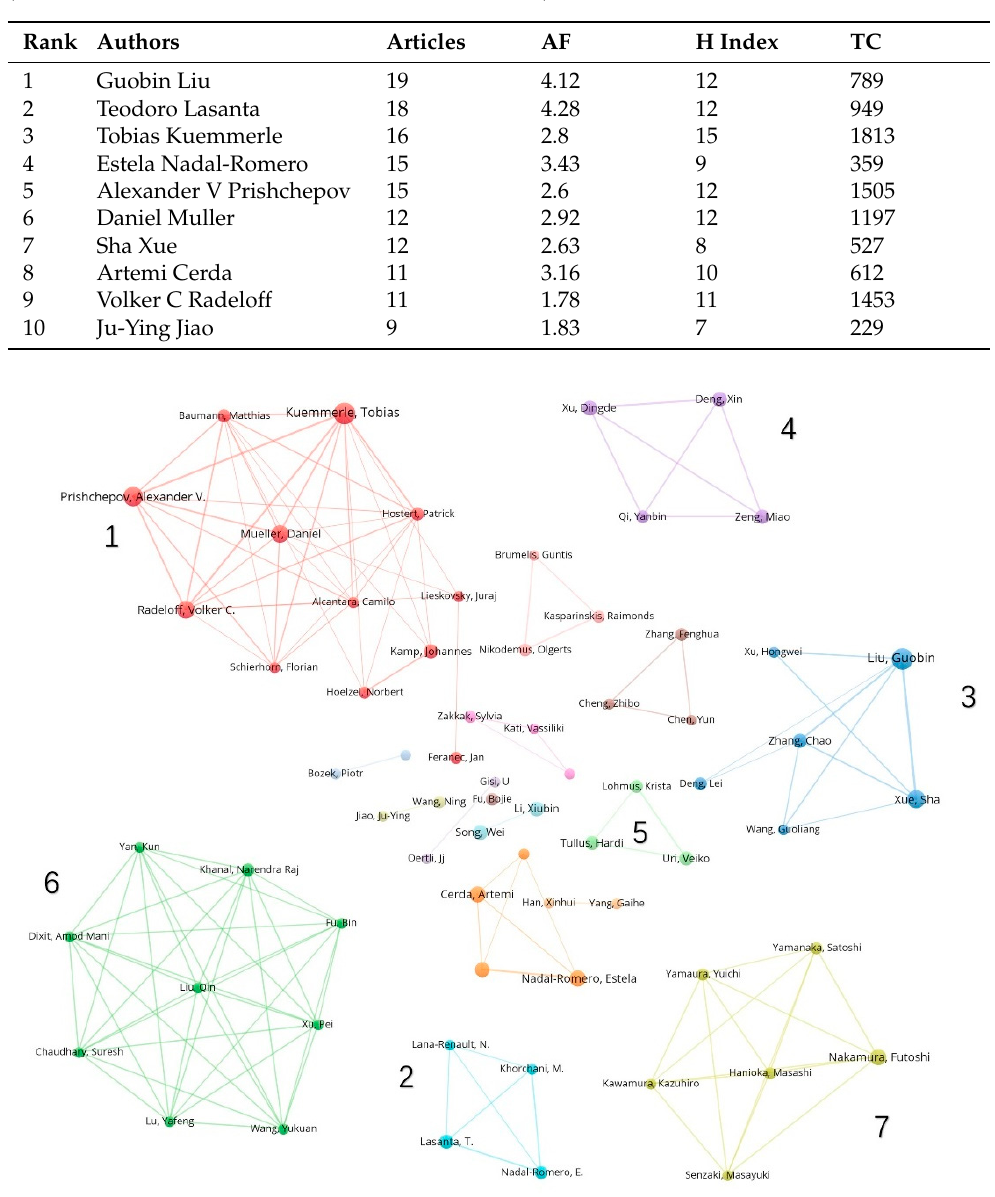
Table 2. Top 10 most relevant authors in the field of farmland abandonment from 1980 to 2021 (Note: AF = articles fractionalized; TC = total citations).